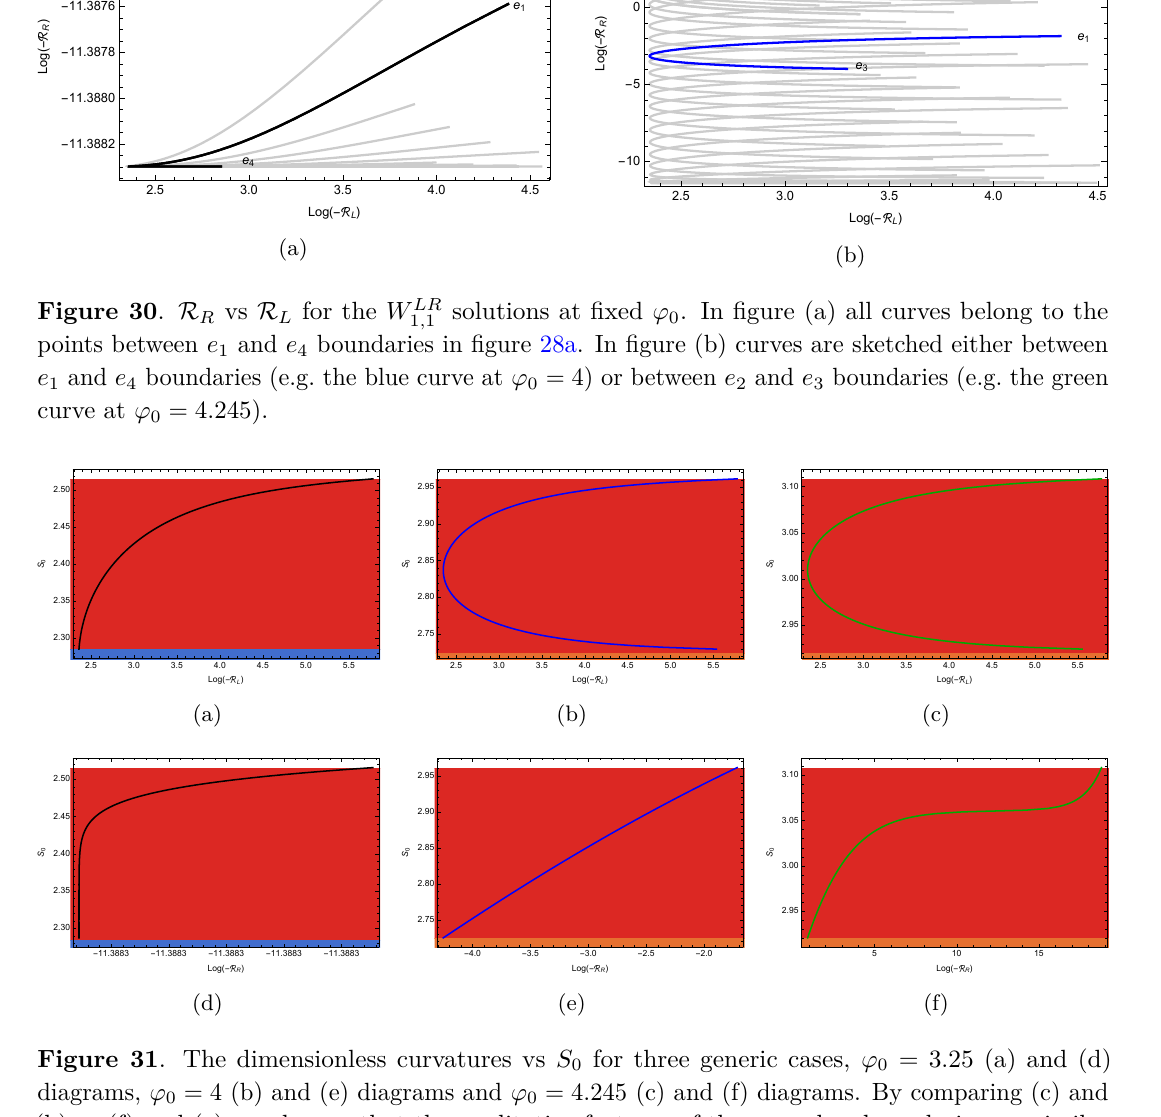
= 4 . 245 (c) and (f) diagrams. By comparing (c) and 0 and e boundaries are similar 1 2